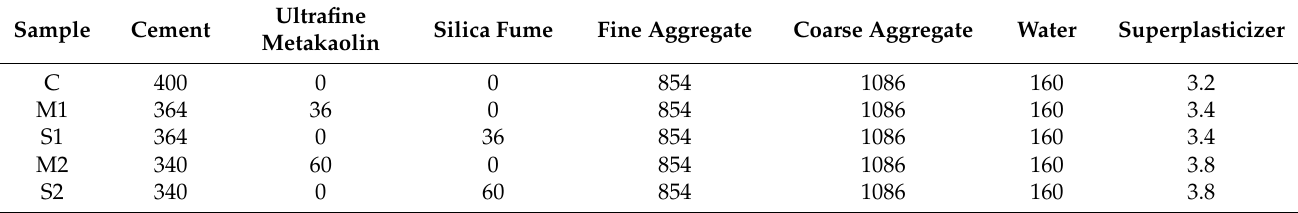
Table 2. Mix proportions of concretes/kg · m − 3